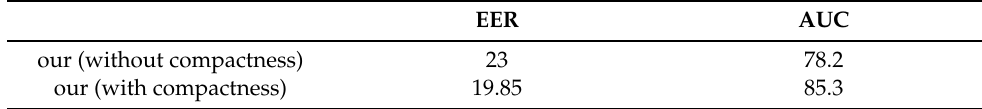
Table 4. Compactness loss